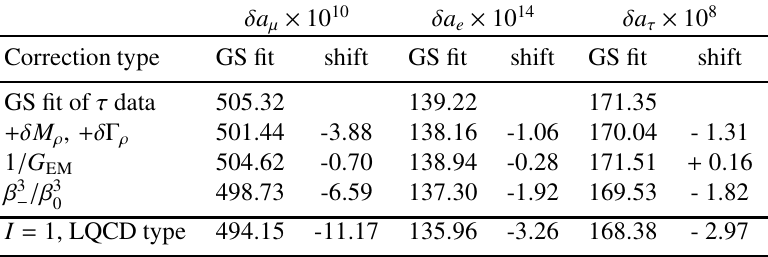
Table 4. Charged channel: missing e ff ects in lattice QCD simulations performed in the isospin limit m d = m u and without QED e ff ects. Tabulated are the e ff ects δ a ℓ ( ℓ = µ. e ,τ ) integrated from 300 MeV to 1 GeV